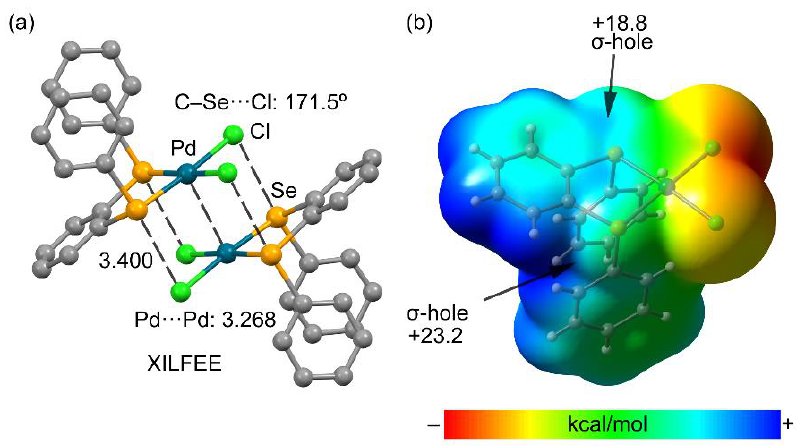
Figure 5. ( a ) Partial view of refcode XILFEE structure. Distances in Å . H-atoms omitted for clarity. ( b ) MEP surface (isodensity 0.001 a.u.) of XILFEE. The energies at the σ -holes are indicated in kcal/mol.